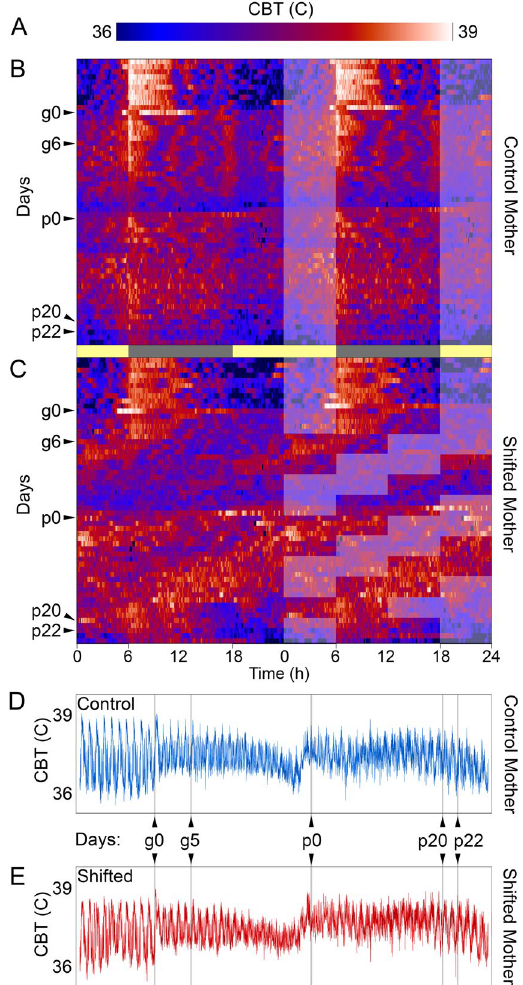
Figure 2. DCCD impacts maternal physiological rhythms. Color maps of intensity ( A ) reveal stable daily rhythms core body temperature (CBT) in sensor-implanted dams from control ( B ) and shifting ( C ) dams before onset of DCCD. Double-plotted actograms, with light-phase overlaid on the right half. After onset of DCCD, shifting dams show expected advances in their CBT rhythms in response to advances, which overall give shifting dams 2 additional daily cycles during their pregnancies (48 h accumulated advance). Nevertheless, pregnancies are of the same duration for control ( D ) and shifting ( E ) dams, as revealed by the stereotyped profile of CBT changes across